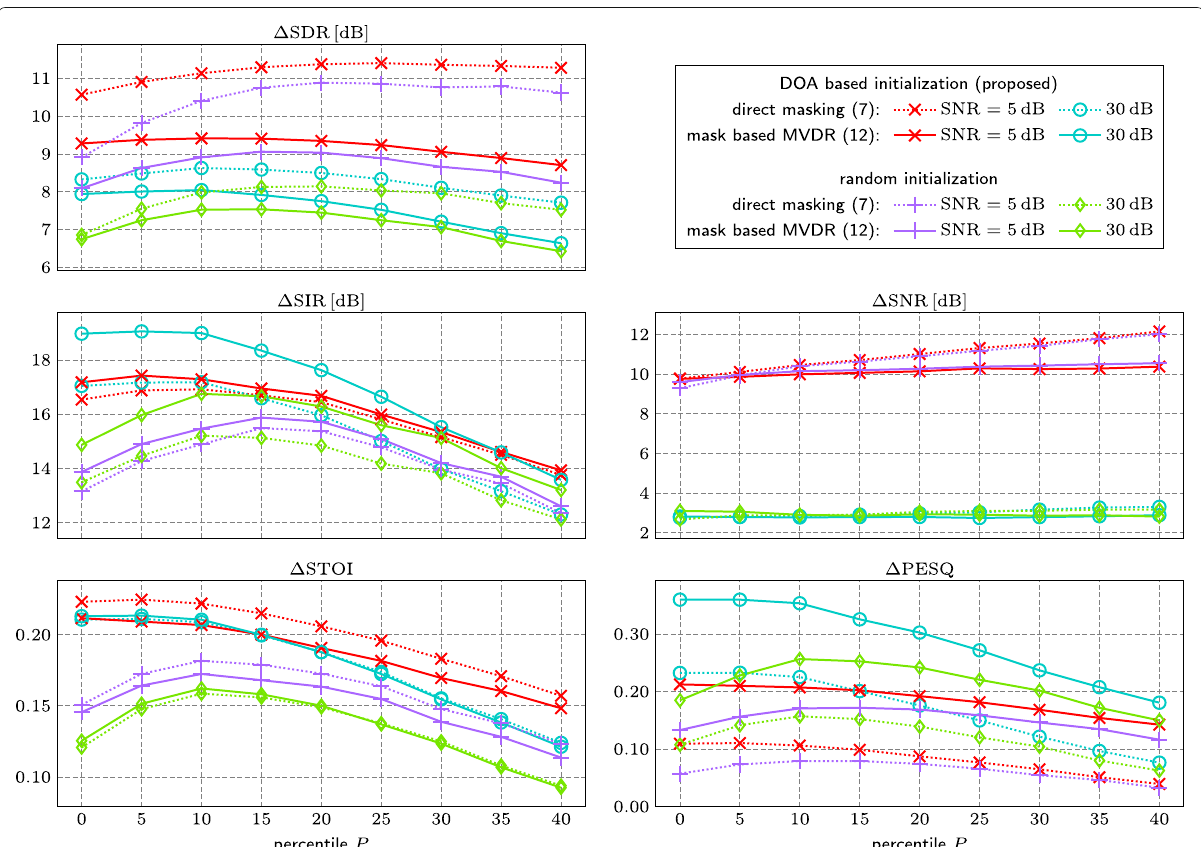
Fig. 8 Evaluation results as a function of the parameter P that is used in the computation of the STAs. When the masks are initialized randomly, the performance peaks around P = 10, whereas the proposed initialization permits the STAs to be omitted ( P = 0 ) for the considered evaluation setup